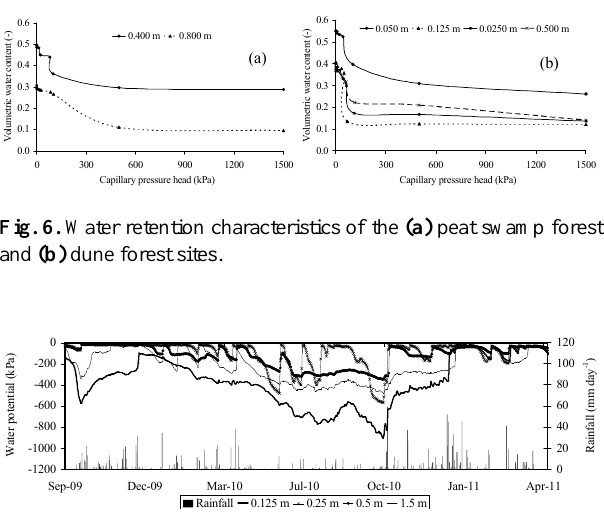
in water potential with depth indicating that the profile be- came drier with depth beyond 0.25